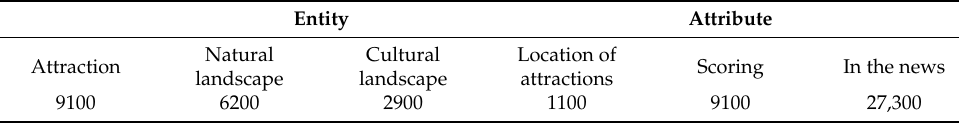
Table 3. The data statistics of knowledge